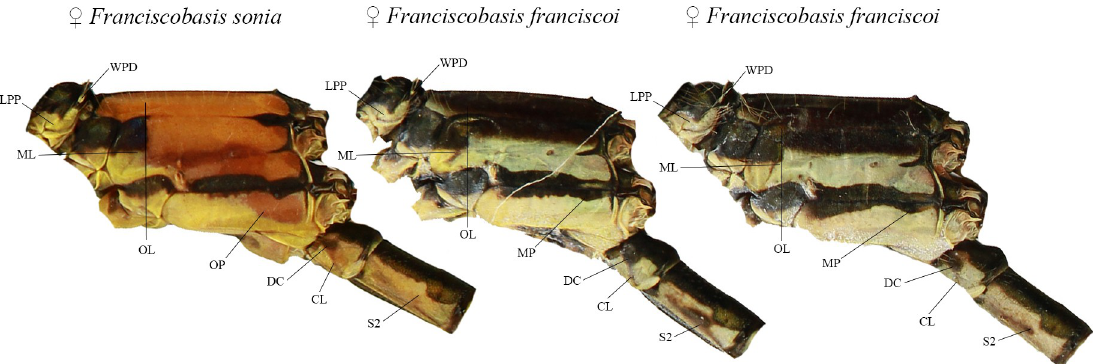
Fig 3. Coloration similarities between Franciscobasis sonia and F . franciscoi . WPD: White posterior lobe dot; LPP: lateral prothoracic pattern; ML: Mesepisternum line; OL: Orange vertical limit of mesepimeron and metepisternum; OP: Orange metepimeron patch only found in F . sonia ; MP: metepimeron black stripe; DC: Dark circle on segment 1; CL: Circle oblique dark line; S2: Color pattern of segment 2.